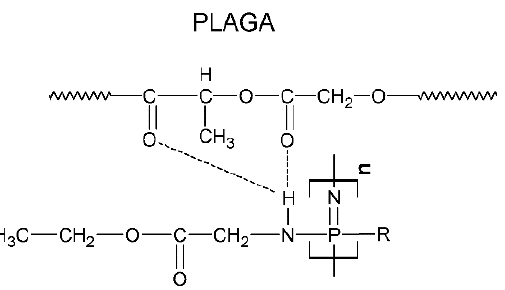
Figure 21. Biodegradable glycine containing polyphosphazenes for bone regeneration.